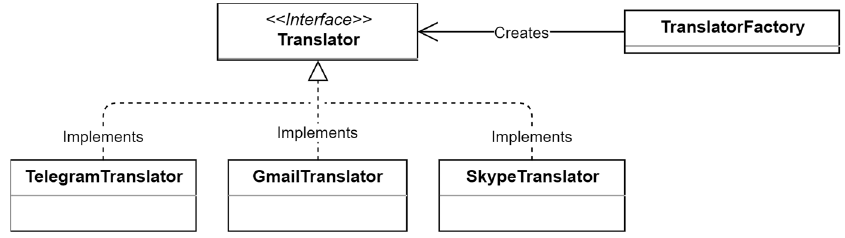
Figure 4. UML class diagram of the translator